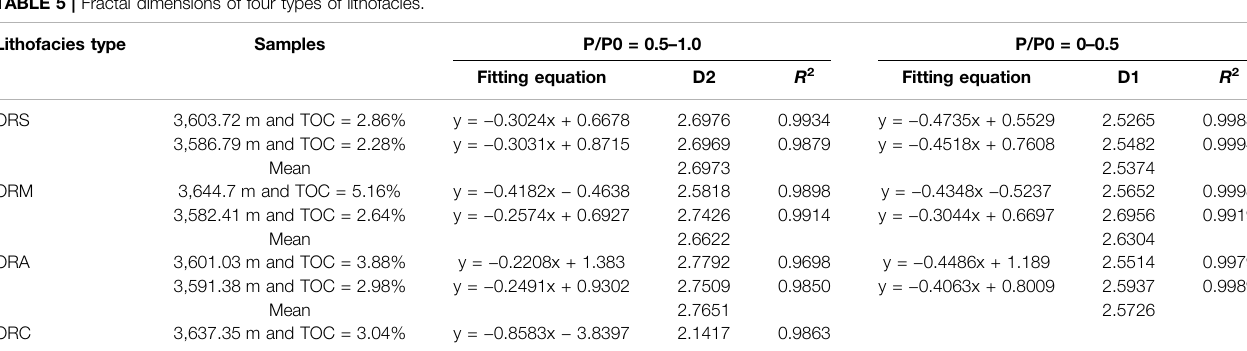
TABLE 5 | Fractal dimensions of four types of